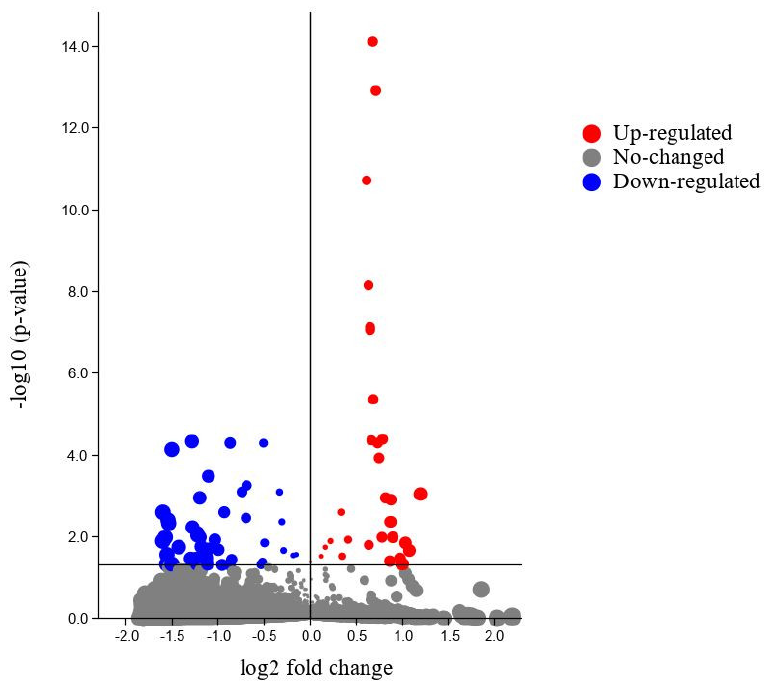
Figure 2. Differentially expressed genes identified in blood-fed and starved bed bugs. Table 3. DEGs in blood fed and starved tropical bed